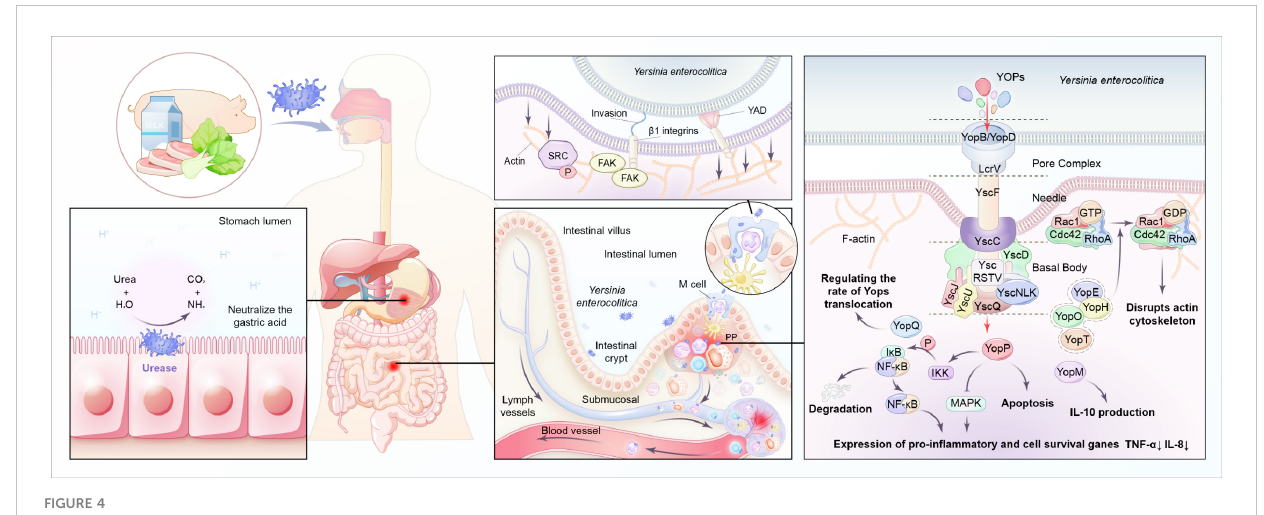
FIGURE 4 Pathogenic mechanisms of Y.